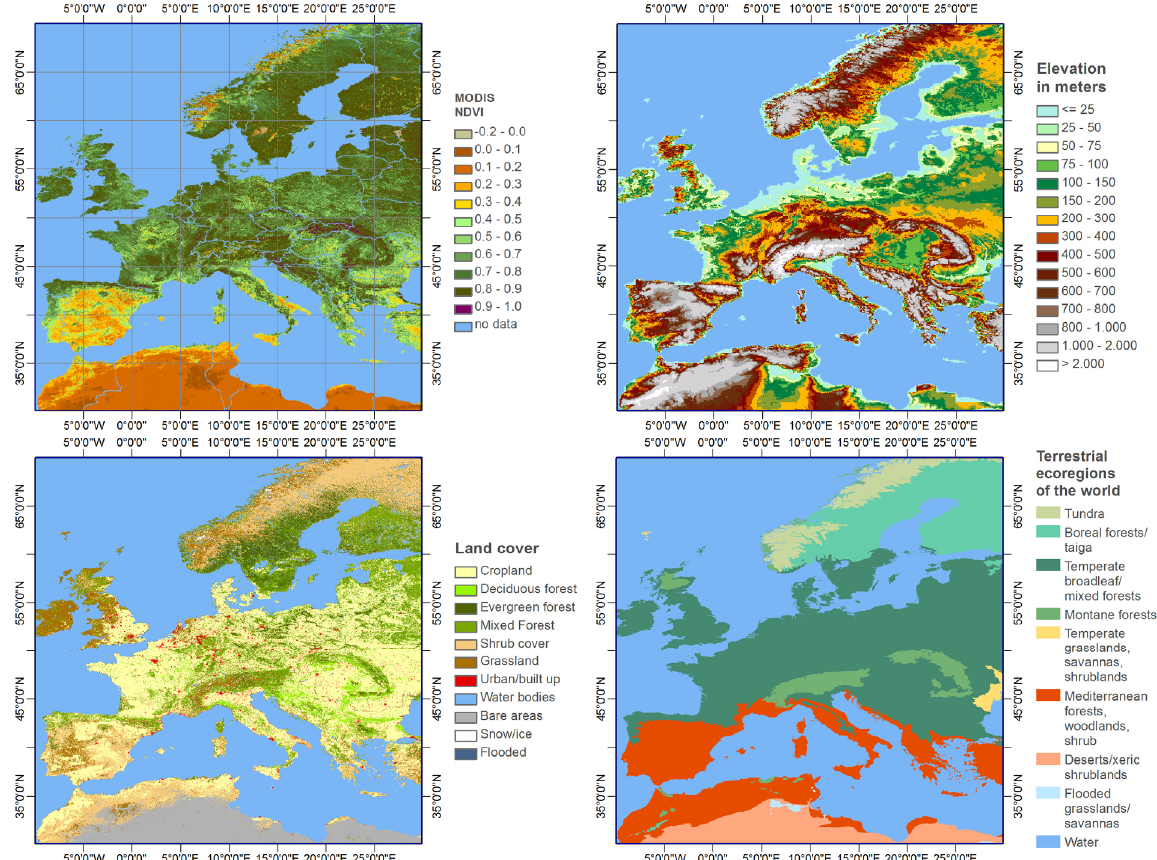
Figure 1. Study area and general environmental conditions. ( top left ) typical NDVI values in the study area in July, ( top right ) mean elevation [56], ( center left ) recoded land cover type 1 product MCD12Q1 v005 from MODIS [23,60], ( center right ) terrestrial ecoregions of World Wildlife Fund (WWF) [57], ( bottom left ) annual mean temperature [58], ( bottom right ) annual mean precipitation